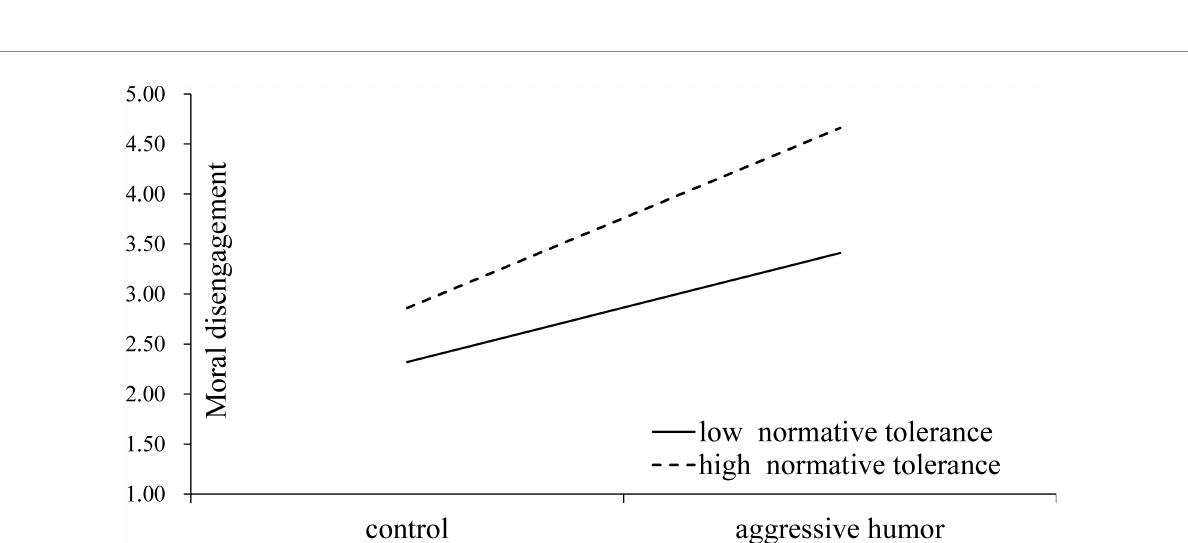
FIGURE 3 Joint effect of aggressive humor and online normative tolerance on moral